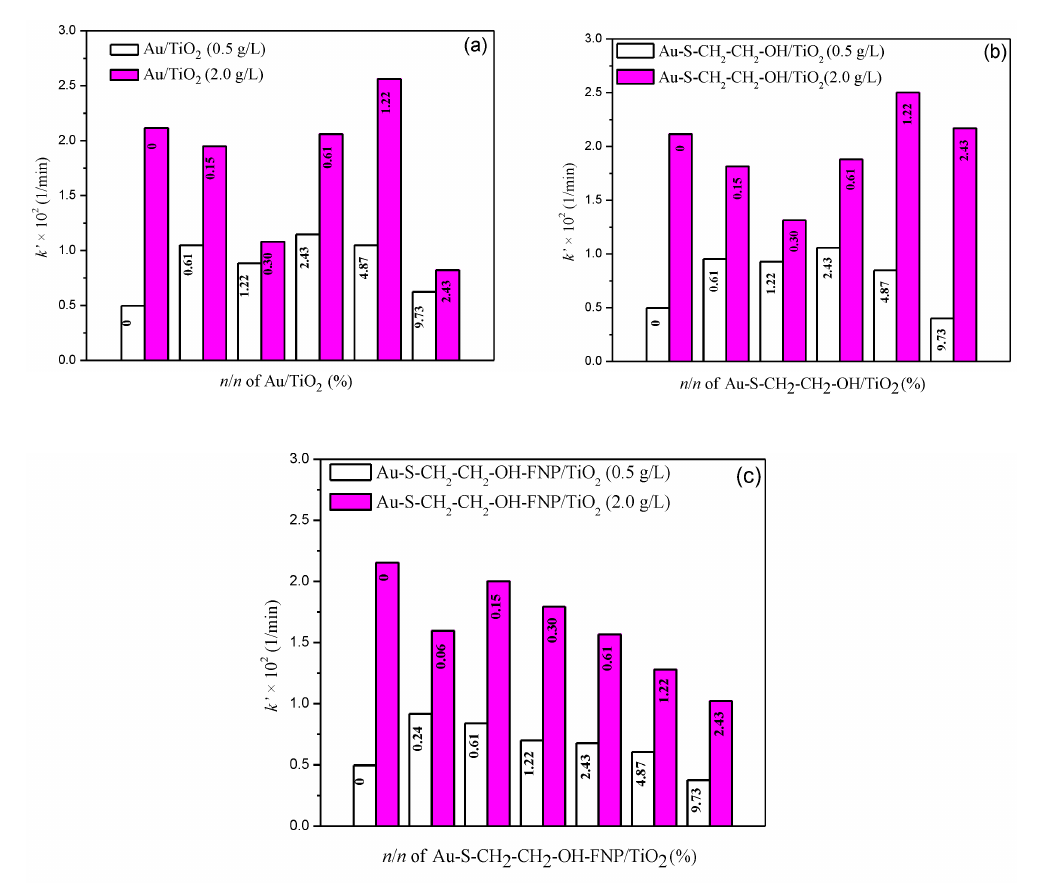
Figure 5. The influence of di ff erent n / n × 10 3 (%) of: ( a ) Au; ( b ) Au–S–CH 2 –CH 2 –OH; and ( c ) Au–S–CH 2 –CH 2 –OH–FNP / TiO 2 (0.5 g / L and 2.0 g / L) on the k (cid:48) determined for the first 120 min of mesotrione (0.05 mM) photocatalytic degradation under simulated